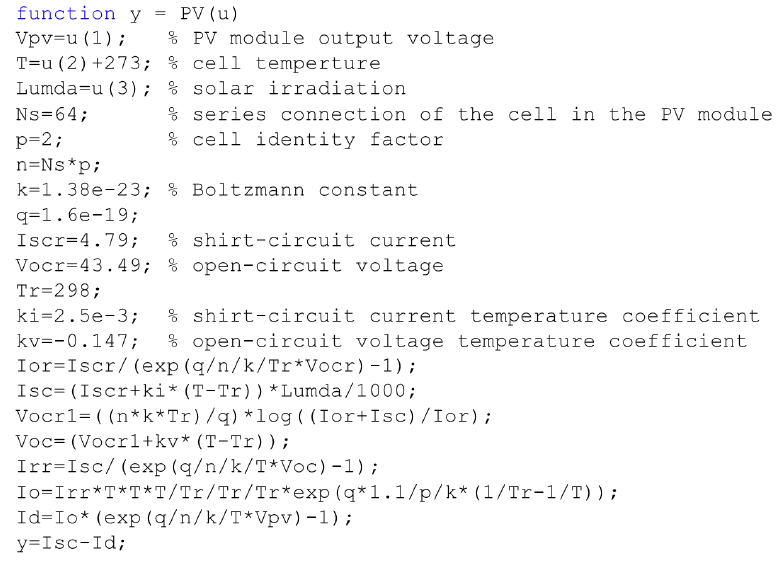
Figure 11. T H e PV module function.